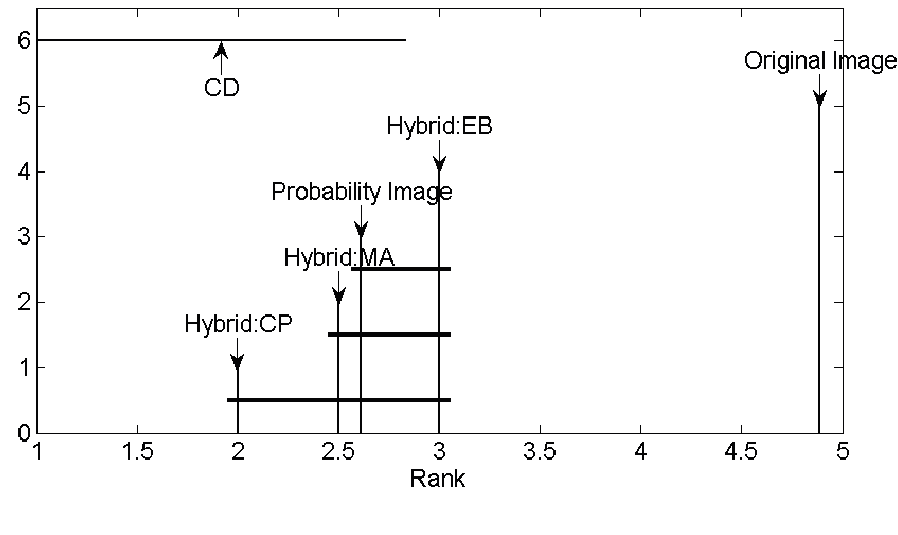
Figure 11. The Nemenyi post hoc test, with the RBSB metric omitted. Horizontal lines indicate the Critical Differences